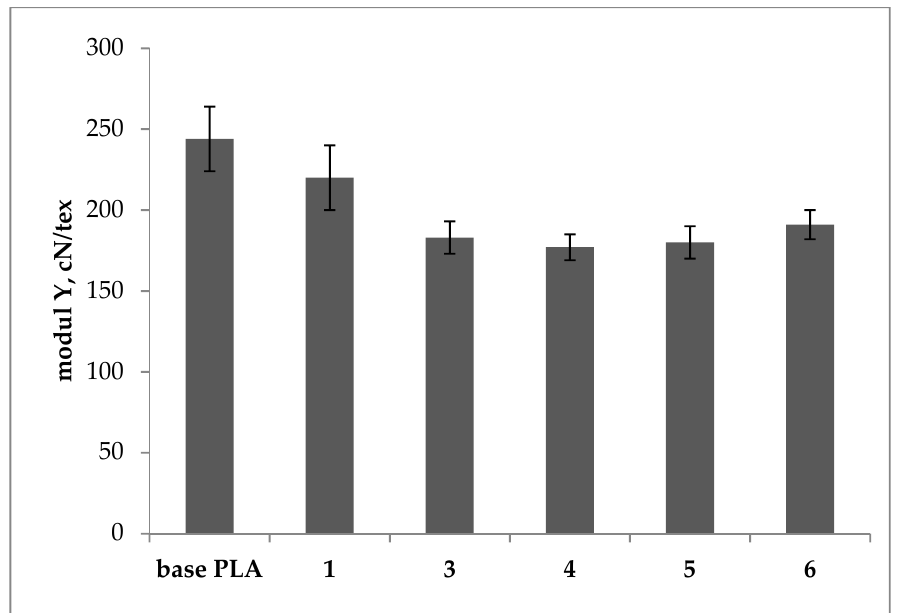
Figure 9. Young’s modulus of the base and plasticized PLA filaments.